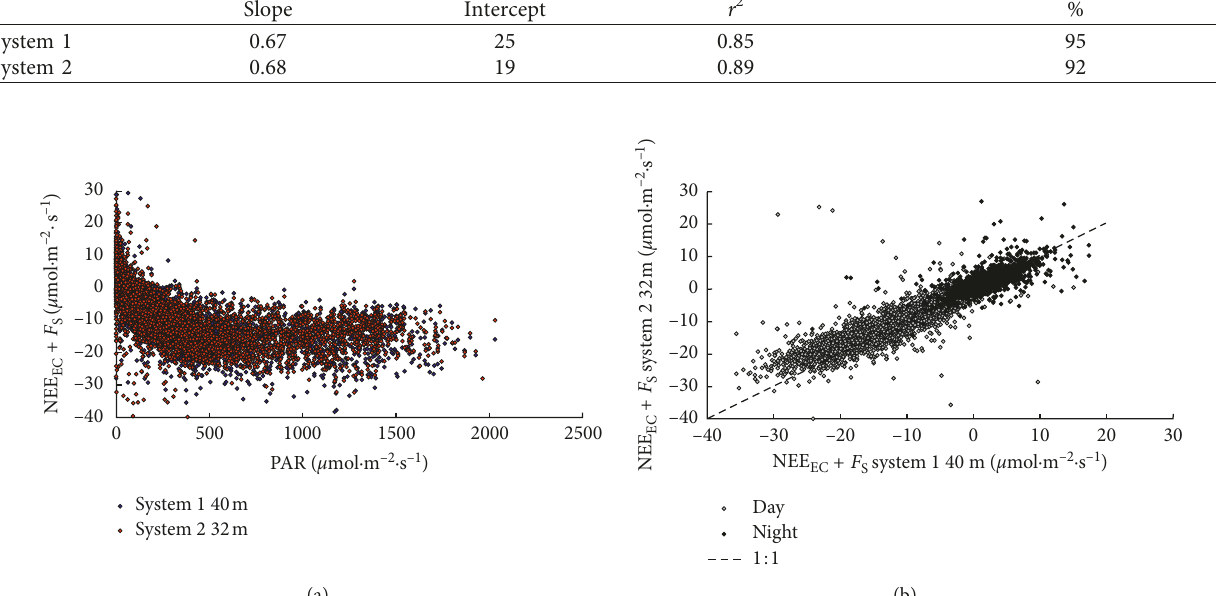
Figure 2: (a) Scatter plot of NEE EC + F S against PAR; blue symbols show data from system 1 at 40 m agl.; red symbols refer to system 2 at 32m agl. (b) Scatter plot of NEE EC + F S system 1 against NEE EC + F S system 2; black is nighttime data; light grey data points represent daytime data; the black dashed line refers to the 1:1